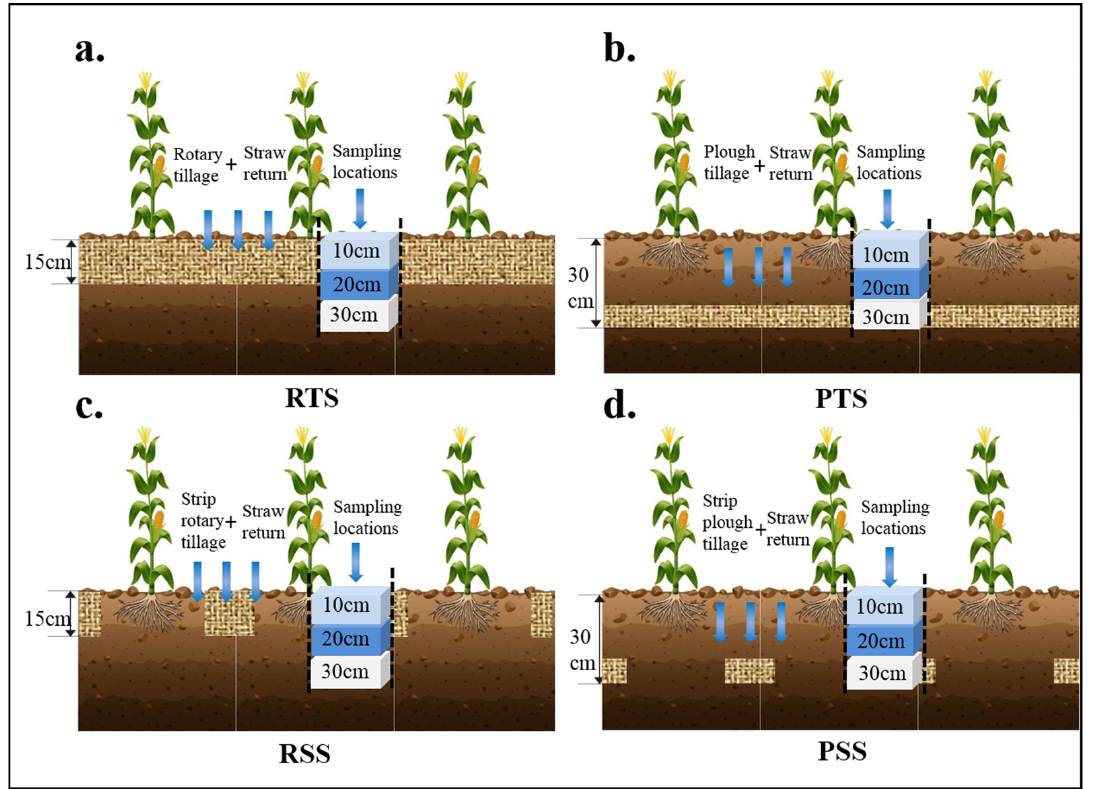
Figure 1. Diagram indicating the straw return mode of each treatment as shown in the figure. ( a ) RTS, rotary tillage with straw return; ( b ) PTS, plow tillage with straw return; ( c ) RSS, rotary tillage with straw strip return; ( d ) PSS, plow tillage with straw strip return, respectively. The tillage layer (0–30 cm) was divided into three layers, topsoil (0–10 cm), mid-soil (10–20 cm) and subsoil (20–30 cm), respectively.